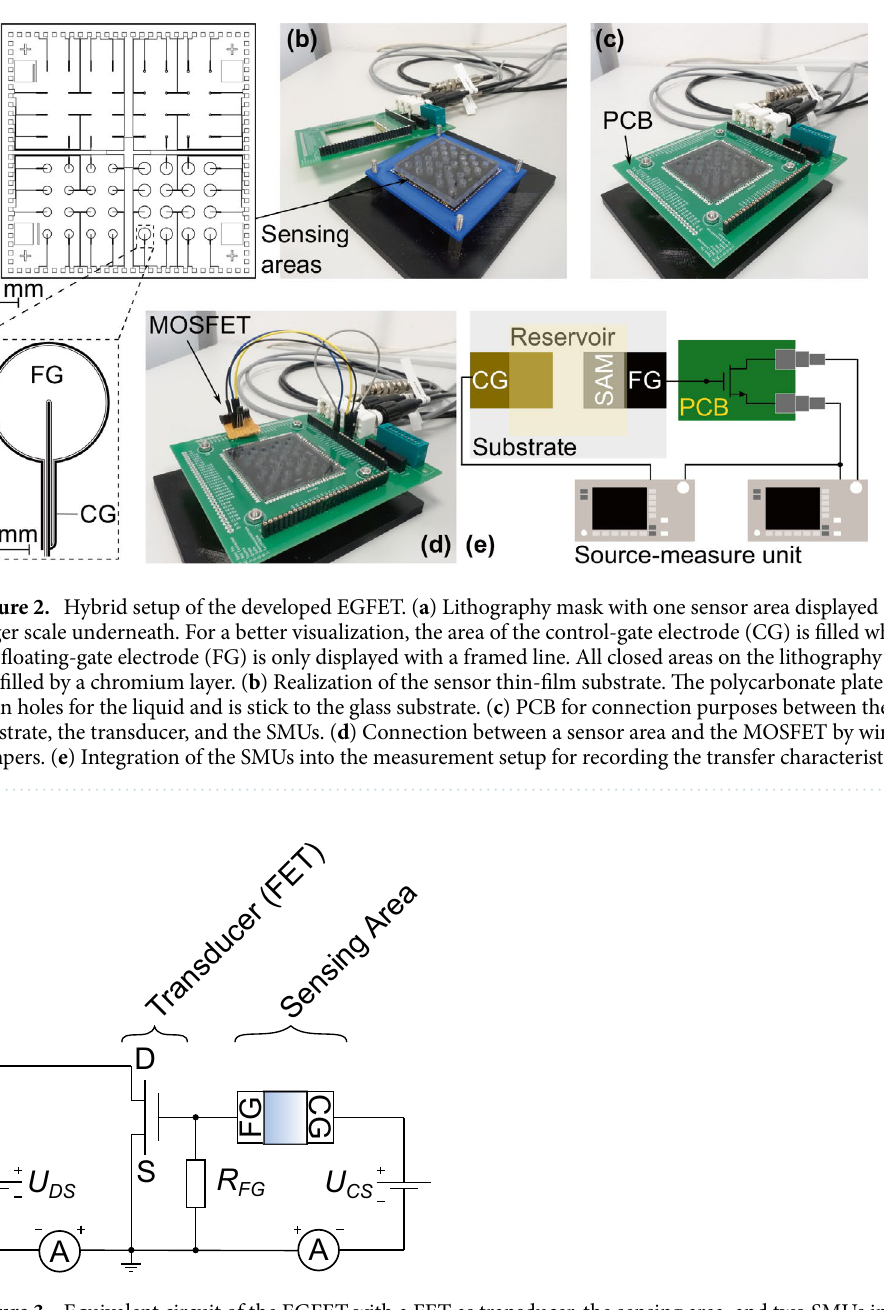
Figure 3. Equivalent circuit of the EGFET with a FET as transducer, the sensing area, and two SMUs including a voltage-source and an amperemeter. Area between FG and CG represents the liquid. D: Drain-electrode, S: Source-electrode, FG: Floating-gate electrode, CG: Control-gate electrode, R FG : Floating-gate resistor, U DS : Drain-source voltage, U CS : Control-gate-source